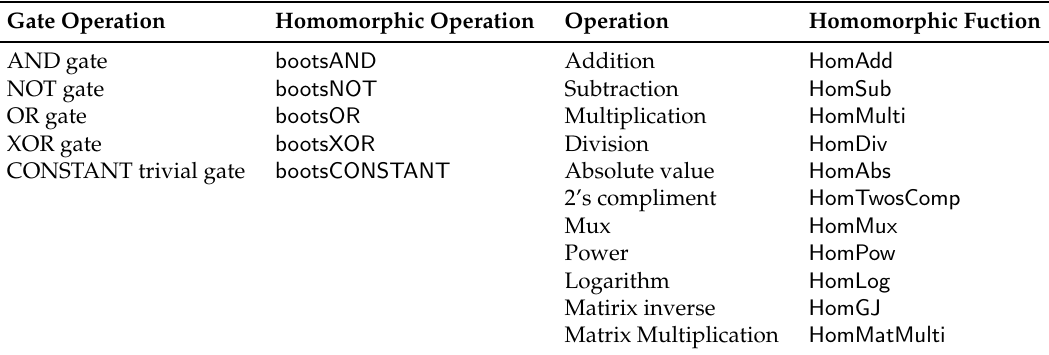
Table 1. The basic notation of homomorphic operations and homomorphic